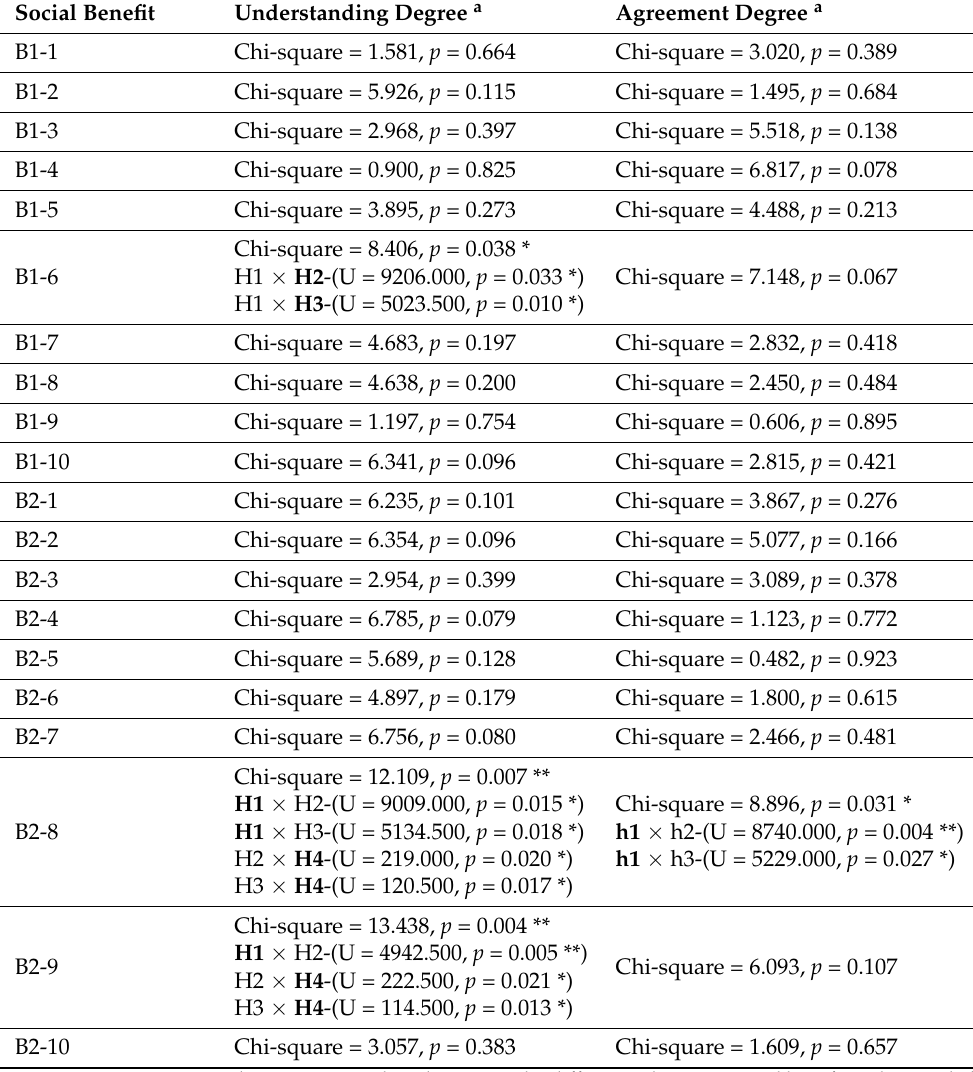
Table 6. The impacts of self-rated health status on respondents’ perceptions of UGS’ social